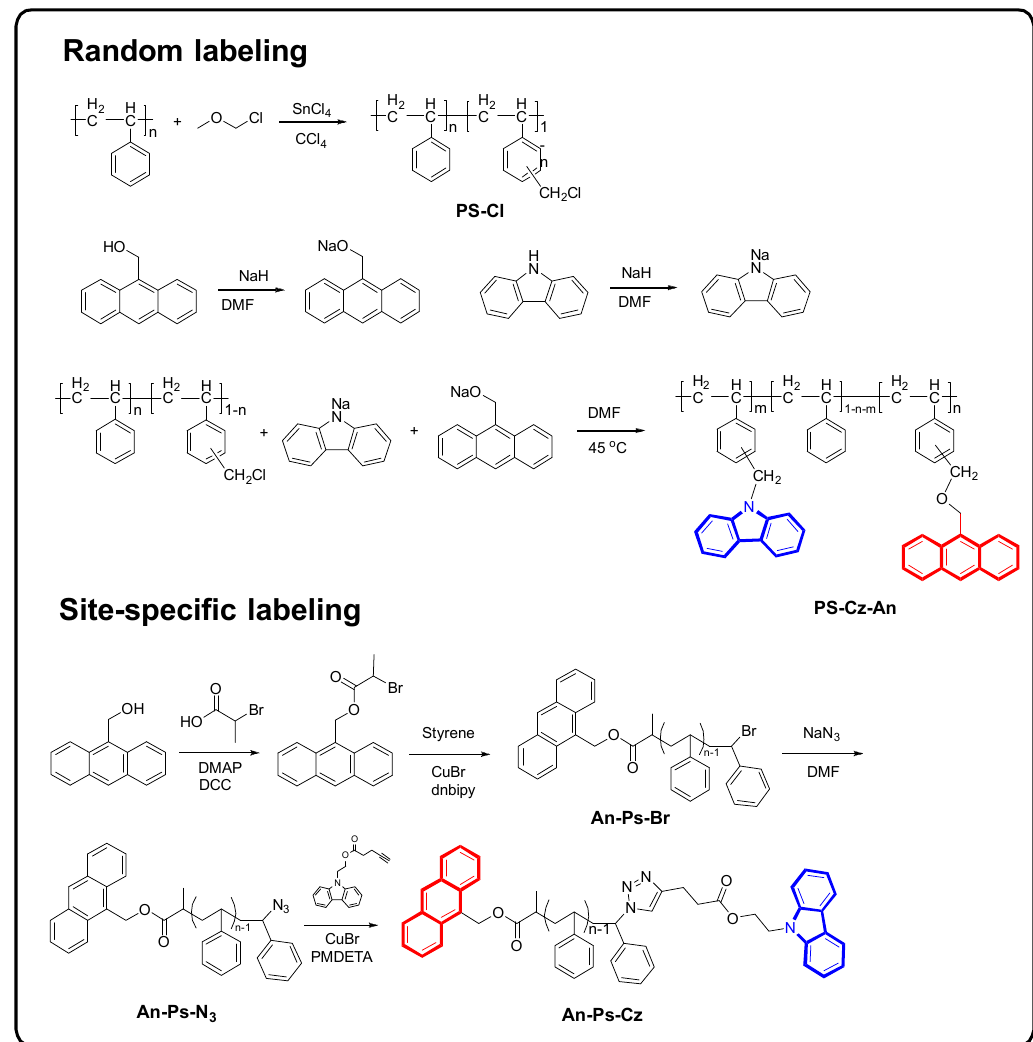
Scheme 1. Synthetic routes of polystyrene (PS) labeled with fluorescent donor and acceptor randomly on chains and specifically in the ends.